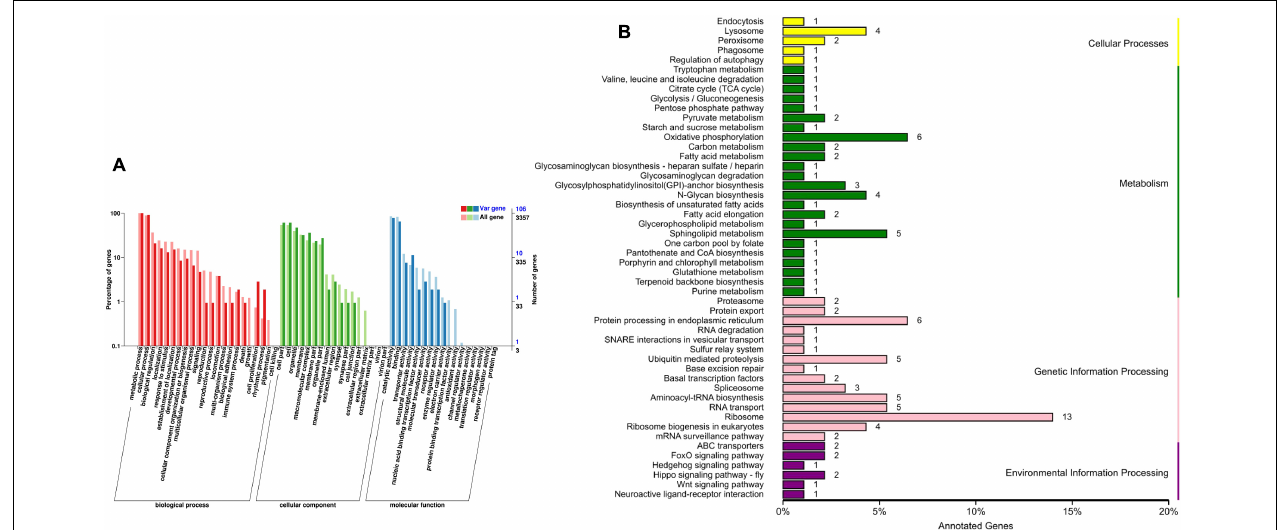
FIGURE 4 | GO and KEGG annotation of the rapid evolution single-copy genes.